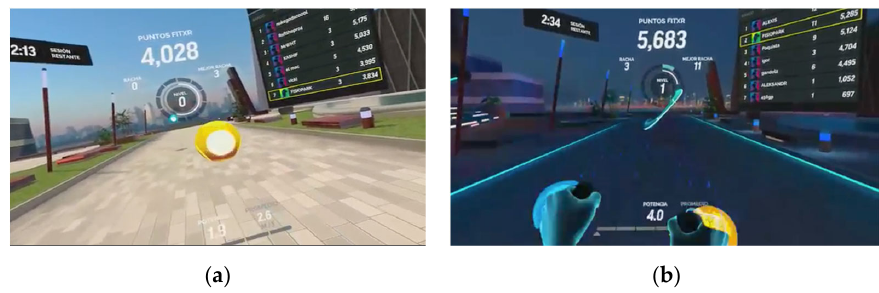
Figure 2. Screenshots of different scenarios of FIT ‐ XR. ( a ) Balls to train upper limbs; ( b ) obstacles to train lower limbs.